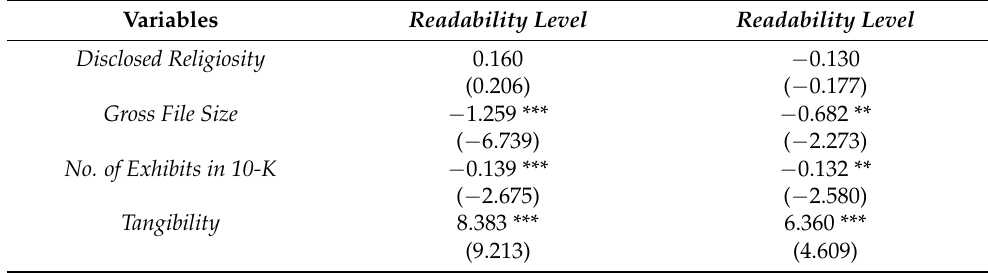
Table 4. Impact of Non-CEO Executive Religiosity on Annual Report